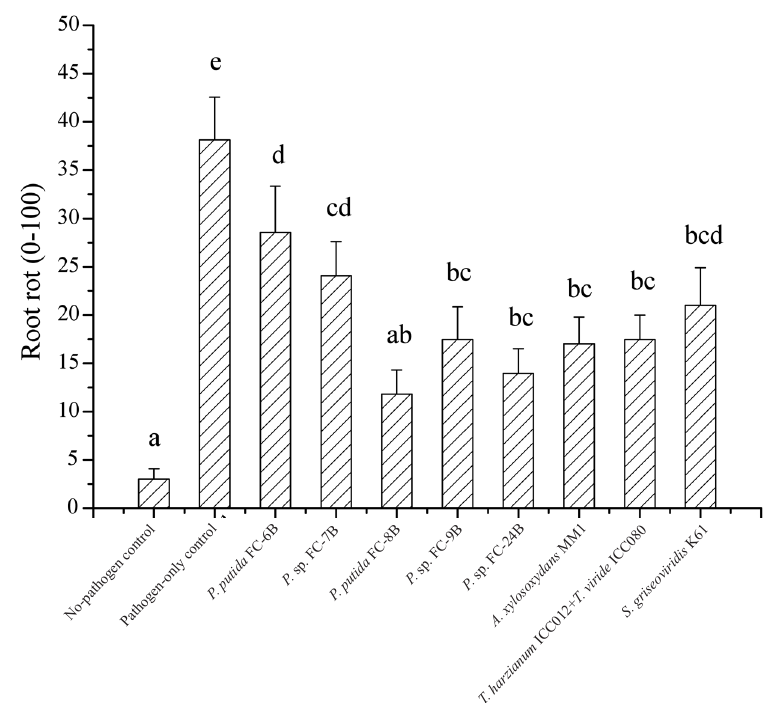
Figure 2. Biocontrol effects of various agents against Fusarium oxysporum f. sp . radicis-lycopersici on tomato in three glasshouse trials evaluated at different days after transplanting (dat), expressed as percent of root rot (RR). Vertical bars represent the standard error (trials 1, 2 and 3). Means designated by the same letter are not significantly different ( P <0.05) according to Duncan’s